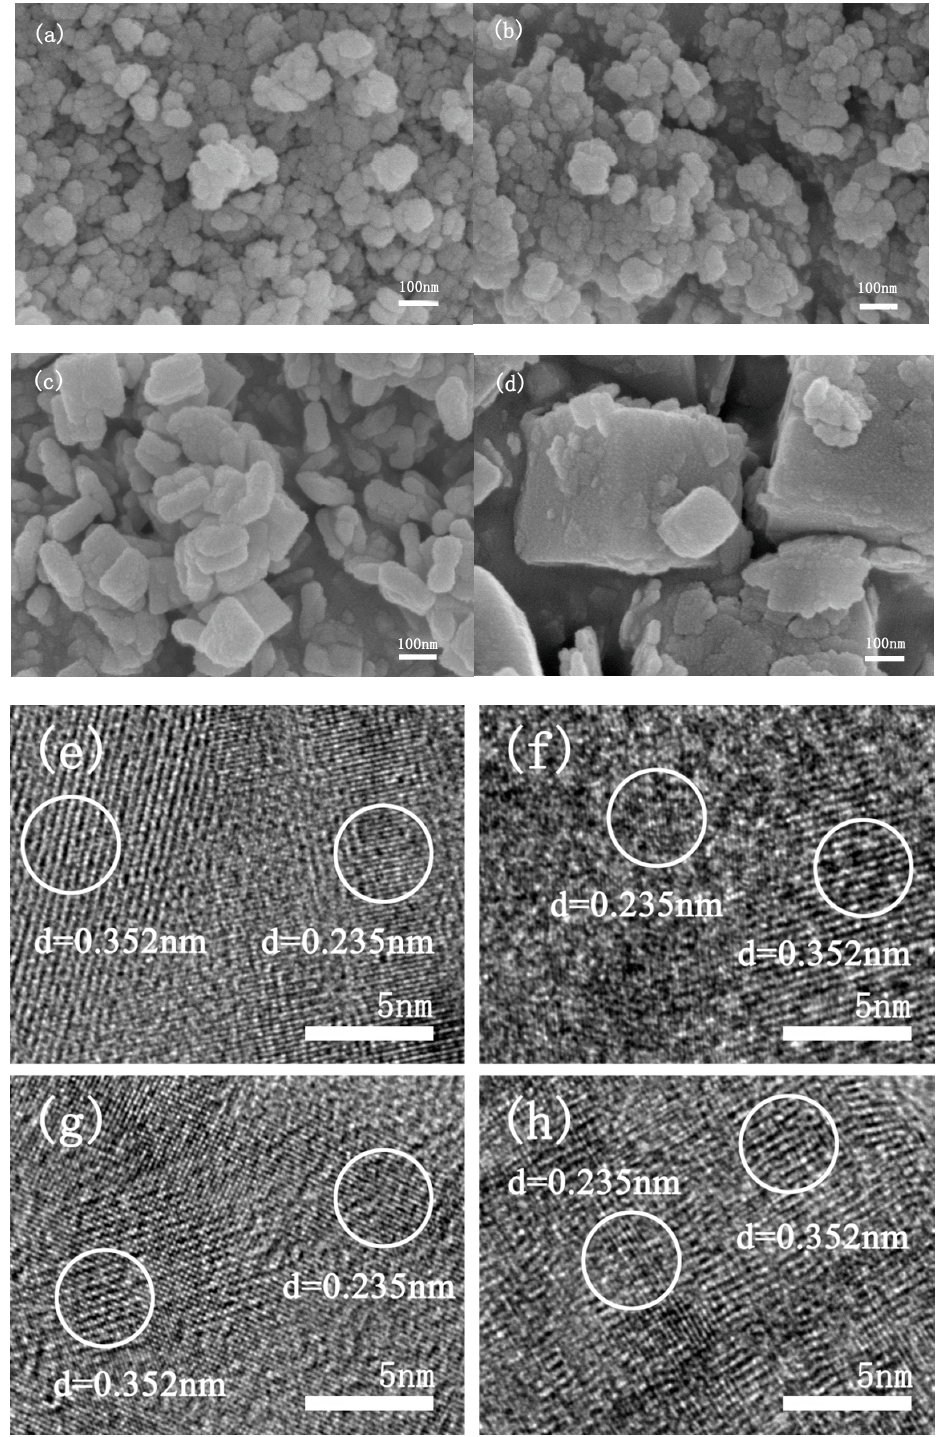
Figure 2. SEM of F6 ( a ), F9 ( b ), F12 ( c ), F15 ( d ), HRTEM of F6 ( e ), F9 ( f ), F12 ( g ), F15 ( h ) .